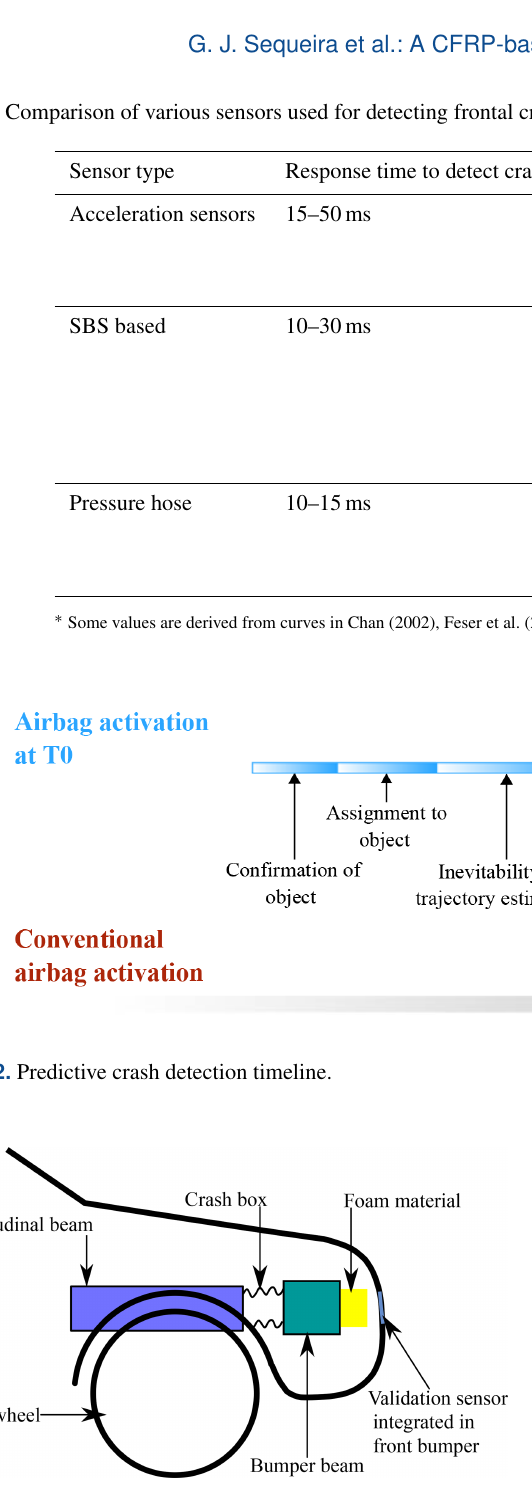
Figure 3. Validation sensor integrated in the vehicle front bumper.